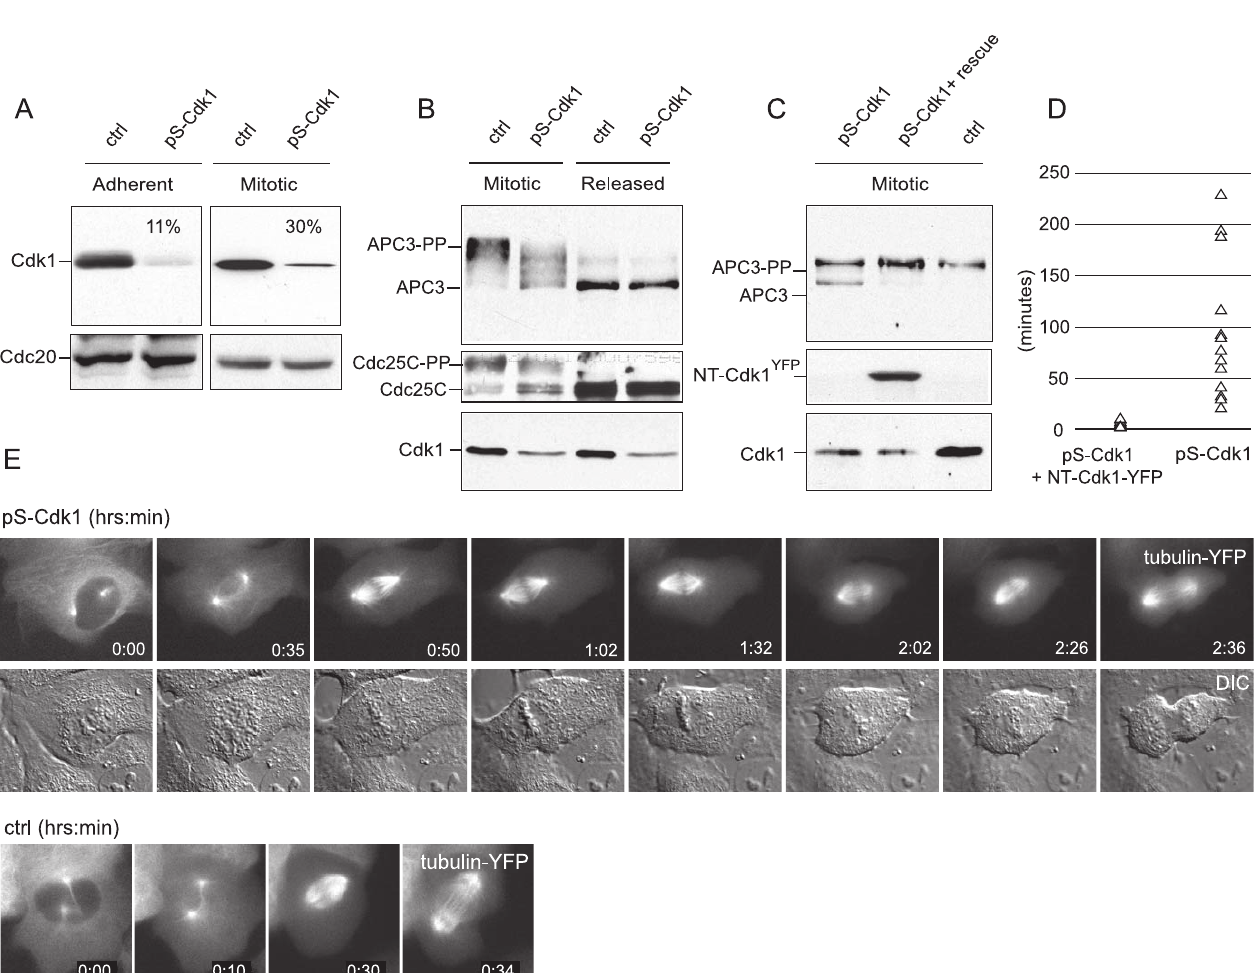
Figure 5. Distinct Requirement of Cdk1 for Mitotic Entry and Mitotic Progression in Human Cells (A) Cells selected for Cdk1 shRNA expression were synchronized in G2/M by thymidine release; mitotic cells were isolated by gentle shake-off. Mitotic cells were more than 95% MPM2 positive as analyzed by immunostaining and FACS analysis (unpublished data). Separated G2 and mitotic pools were analyzed for Cdk1 expression by Western blotting. Cdc20 protein levels serve as loading control. The percentage of remaining Cdk1 protein is indicated in the figure. (B) Cells collected by mitotic shake-off were lysed (lanes 1 and 2) or released from nocodazole and incubated in fresh medium for 3 h, recollected, and lysed (lanes 3 and4). Differences in mitotic phosphorylation shift of APC3 (human Cdc27 ortholog) and Cdc25C, depending on the Cdk1 levels, are shown (lanes 1 and 2). (C) The impaired phosphorylation of APC3 in Cdk1-attenuated mitotic cells (lane 1) was rescued by coexpression of a Cdk1-YFP construct containing a silent mutation in the RNAi targeting region (lane 2). Lane 3 are mitotic cells transfected with a control shRNA, revealing normal endogenous Cdk1 levels. (D) Distribution of metaphase duration, measured as time between chromosome alignment at the metaphase plate and onset of sister chromatid separation, in Cdk1 RNAi cells (right) or Cdk1 RNAi cells rescued by coexpression of non–RNAi-sensitive Cdk1-YFP (left). (E) Time-lapse microscopy analysis of mitotic progression after entry with normal or impaired Cdk1 levels. Bottom panels are consecutive images of tubulin-YFP in a pS-control cell in mitosis; top panels show delayed chromosome alignment (frames 2 and 3) and stalled metaphase (frames 4–6) after Cdk1 shRNA.